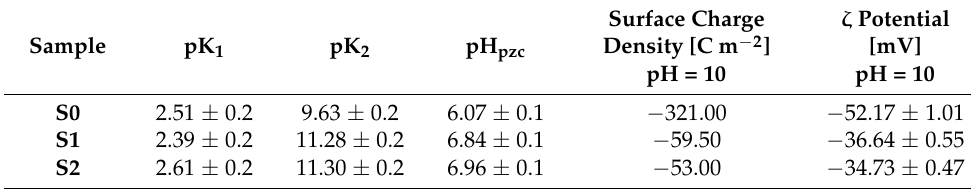
Table 2. Catalysts’ surface